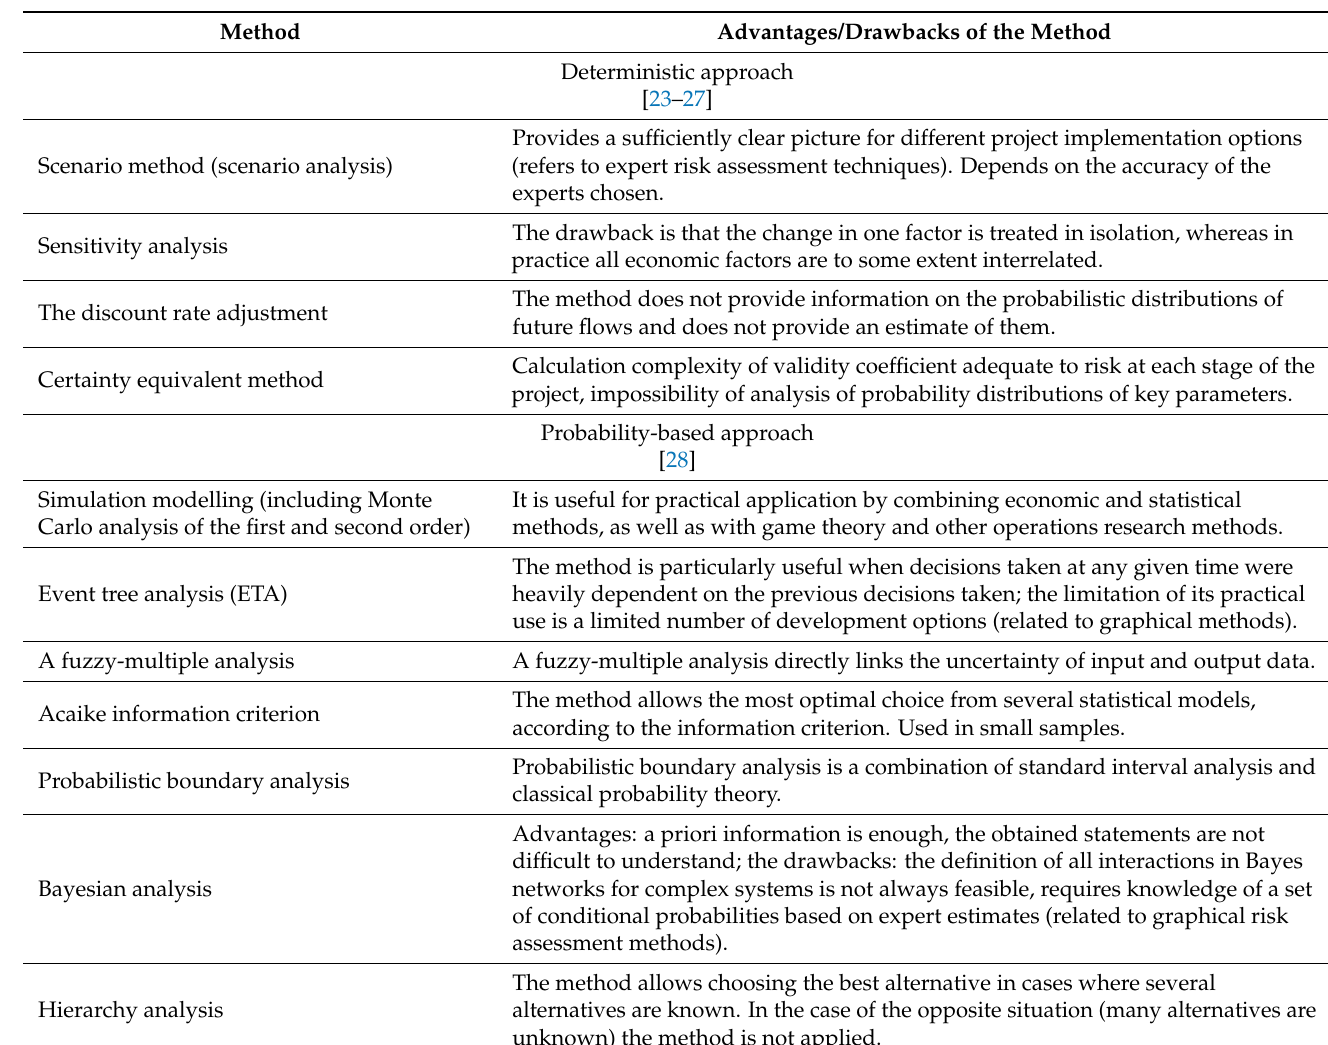
Table 1. The main methods of risk assessment in the framework of deterministic and probabilistic